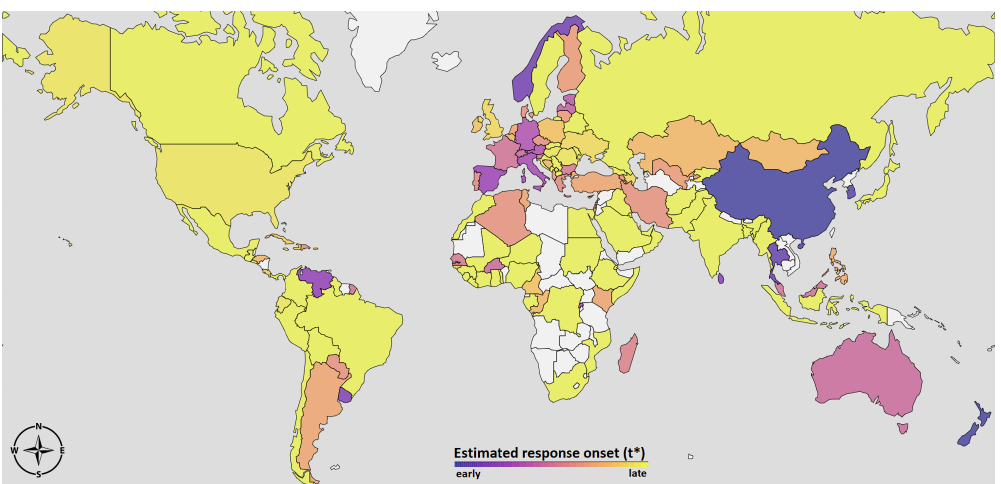
Figure A1. Visualization of the geographic distribution of t ∗ , which provides an estimate of the onset of the social response in each